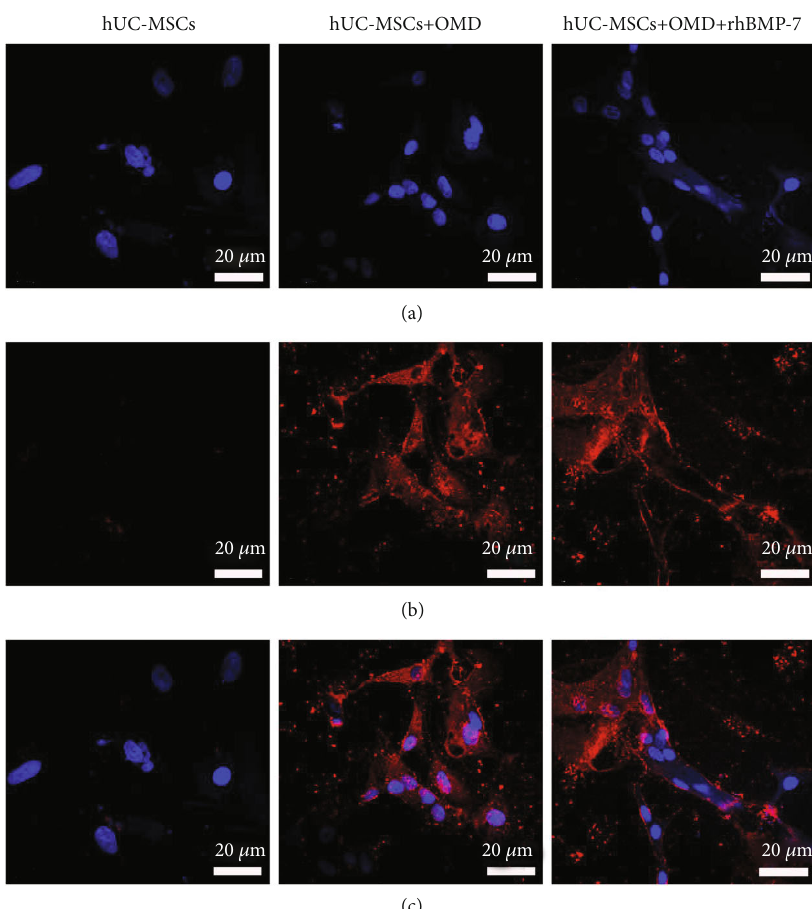
Figure 3: Immuno fl uorescence staining of OCN in hUC-MSCs in the in vitro two-dimensional culture microenvironment for 14 days. (a) DAPI. (b) OCN. (c) Merge. Scale bar = 20 μ m